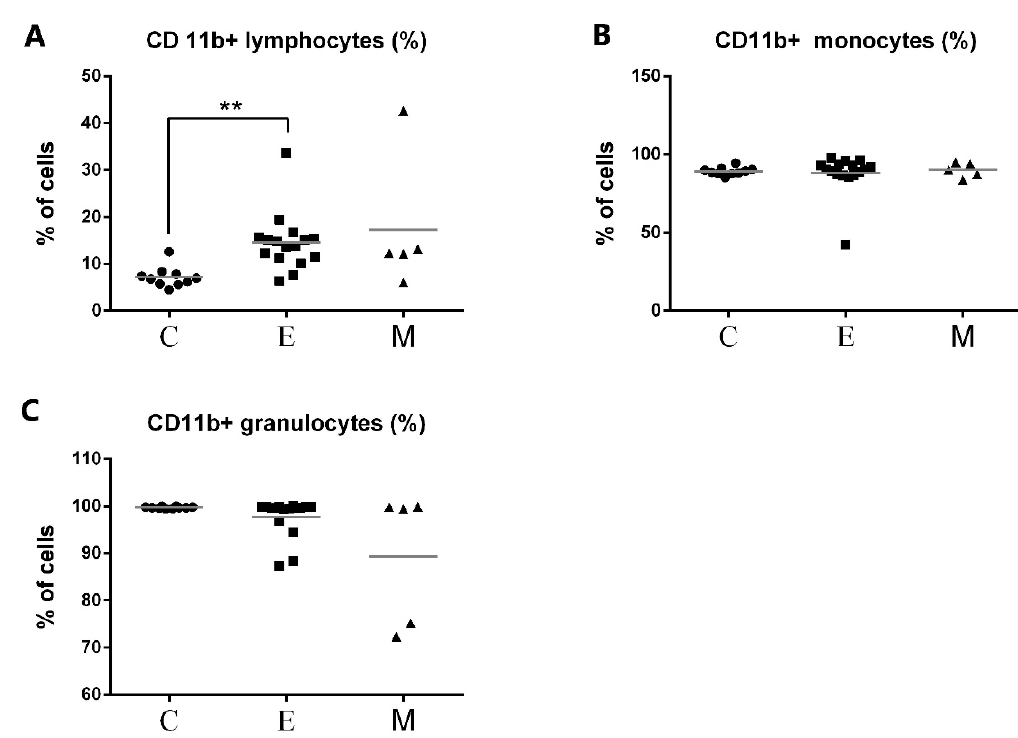
Figure 5. Flow cytometric results showing the mean values of CD11b+ leukocyte percentages in peripheral blood of female dogs with malignant tumors of diverse origin and the control group. Mean values of CD11b+ ( A ) lymphocytes, ( B ) monocytes, and ( C ) granulocytes percentage ( ± SD) in female dogs with tumors of epithelial origin (E); female dogs with tumors of mesenchymal origin (M); and the control group (C). Statistically significant differences at p < 0.01 (**).